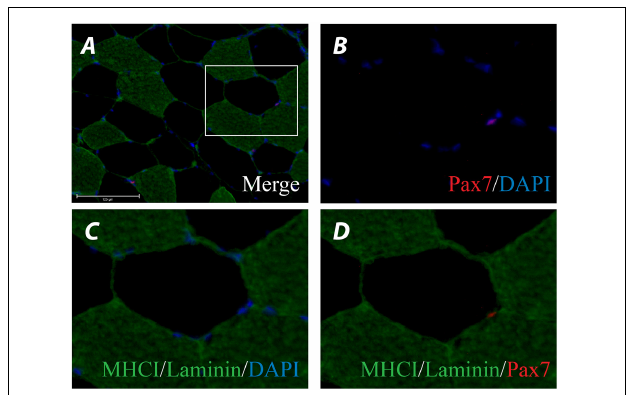
FIGURE 4 | Representative image of a myosin heavy chain (MHC) I/Laminin/Pax7/DAPI stain of a muscle cross-section (A) . Channel view of Pax7/DAPI (B) , MHCI/Laminin/DAPI (C) , and MHCI/Laminin/Pax7 (D)